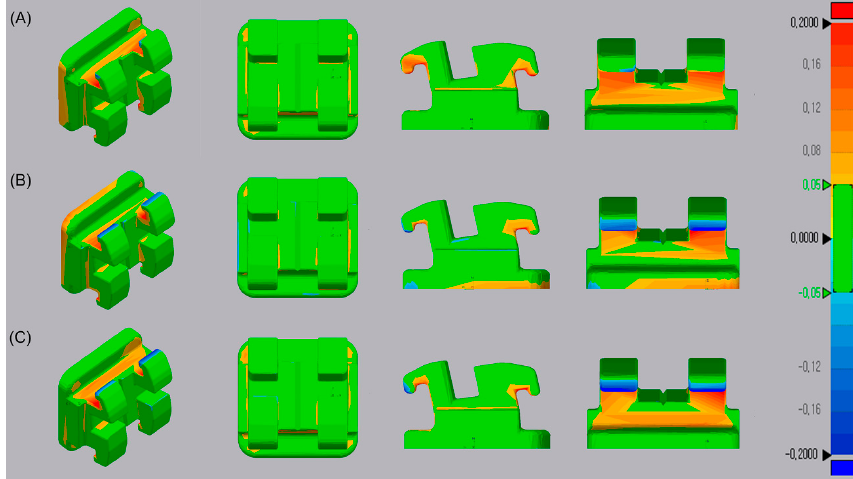
Figure 9. Superimposed optically scanned surfaces of 3D-printed bracket designs and the reference CAD model. ( A ) Control; ( B ) ND-incorporated; and ( C ) A-ND-incorporated. CAD model. ( A ) Control; ( B ) ND-incorporated; and ( C )